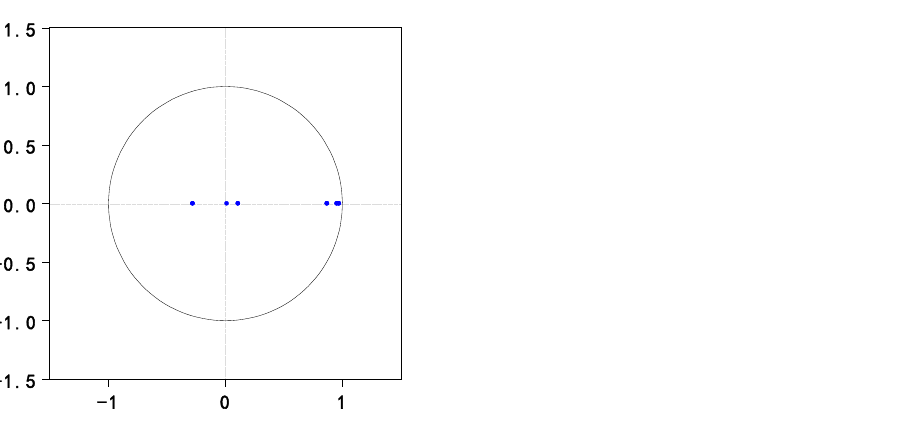
Figure 3. Inverse roots of the PVAR characteristic polynomial. Note: the circle in the figure represents the unit